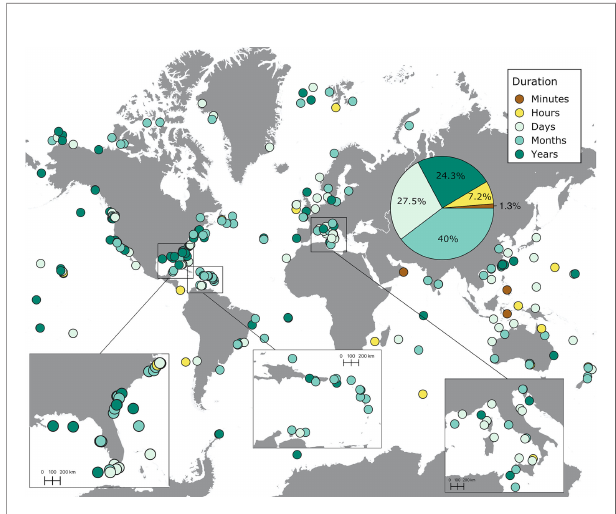
FIGURE 6 | The distribution of the duration of soundscape recordings extracted from published studies on ocean soundscapes (see Supplementary Material for data sources). The pie chart shows the percentage of recordings (out of 305 recordings) conducted for different lengths of time. The duration represents the time elapsed from the fi rst to the end of the last recording in each site, regardless of the frequency of recording within the time period